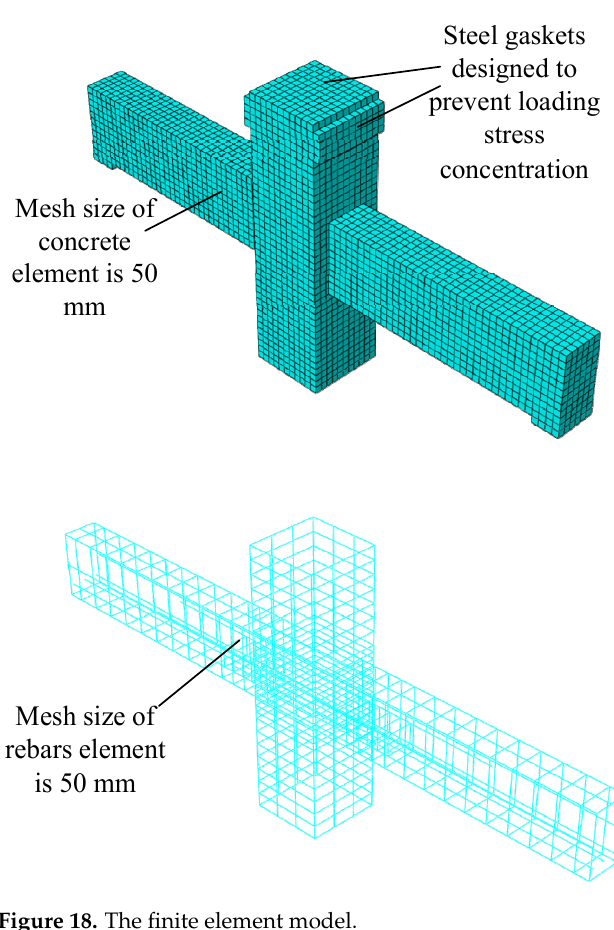
Figure 18. The finite element model .